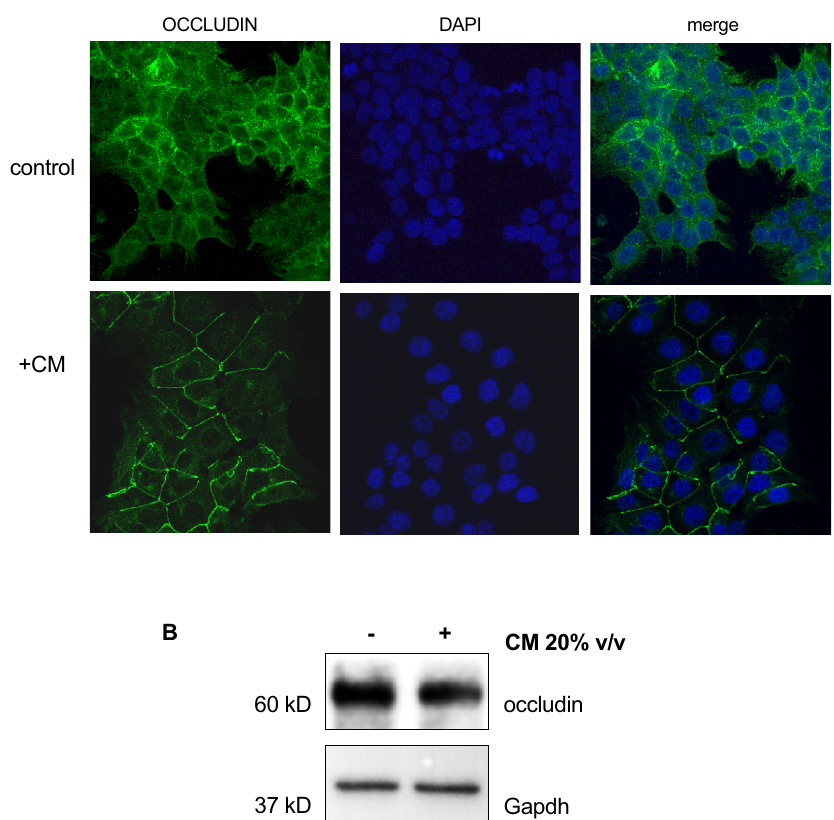
Figure 5. The conditioned Medium of L. gasseri SF1183 affects HCT116 exerts a wider protective effect on HCT116 cells. ( A ) HCT116 cells were seeded onto coverslips and treated with CM for 16 h where indicated. Cells were fixed and analyzed by IF with anti-occludin, followed by DAPI to counter stain the nuclei. Representative images were taken with Zeiss confocal microscope. Scale bar 5 μm. ( B ) HCT116 cells were incubated with CM 20%v/v for 16 h. Cells were collected and extracts were analyzed by western blot with antibodies against occludin and